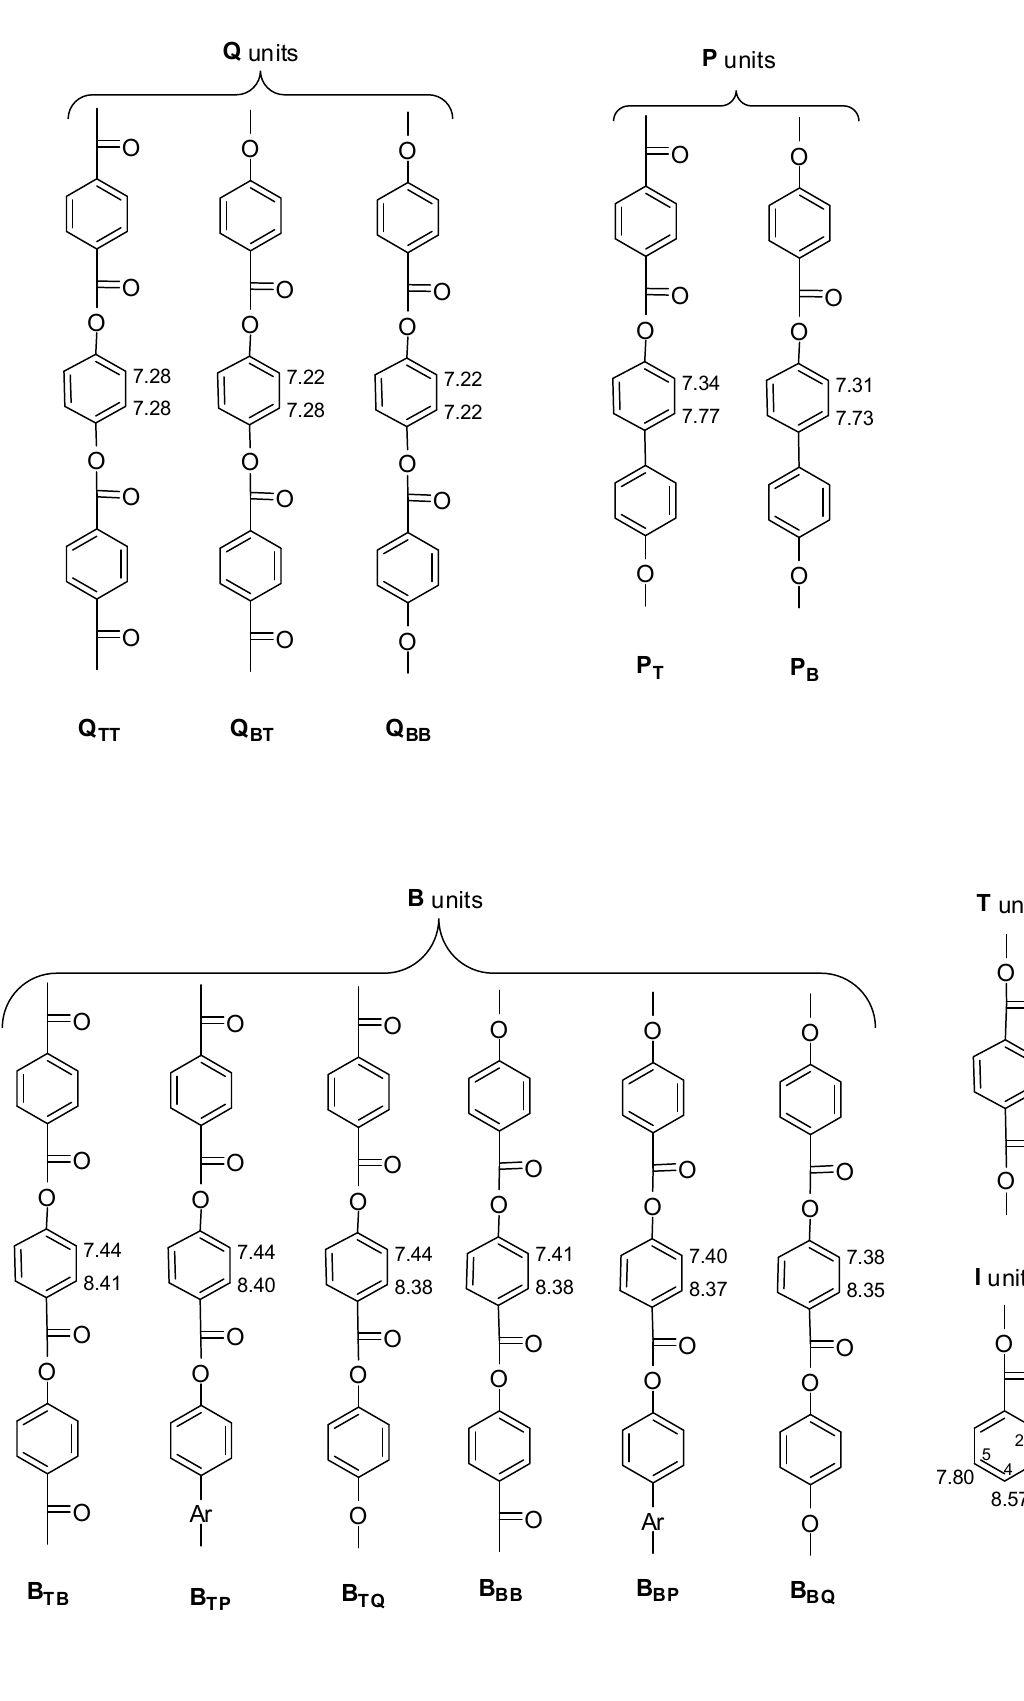
Table 7. 1 H chemical shifts of main chain units of LCP’s in